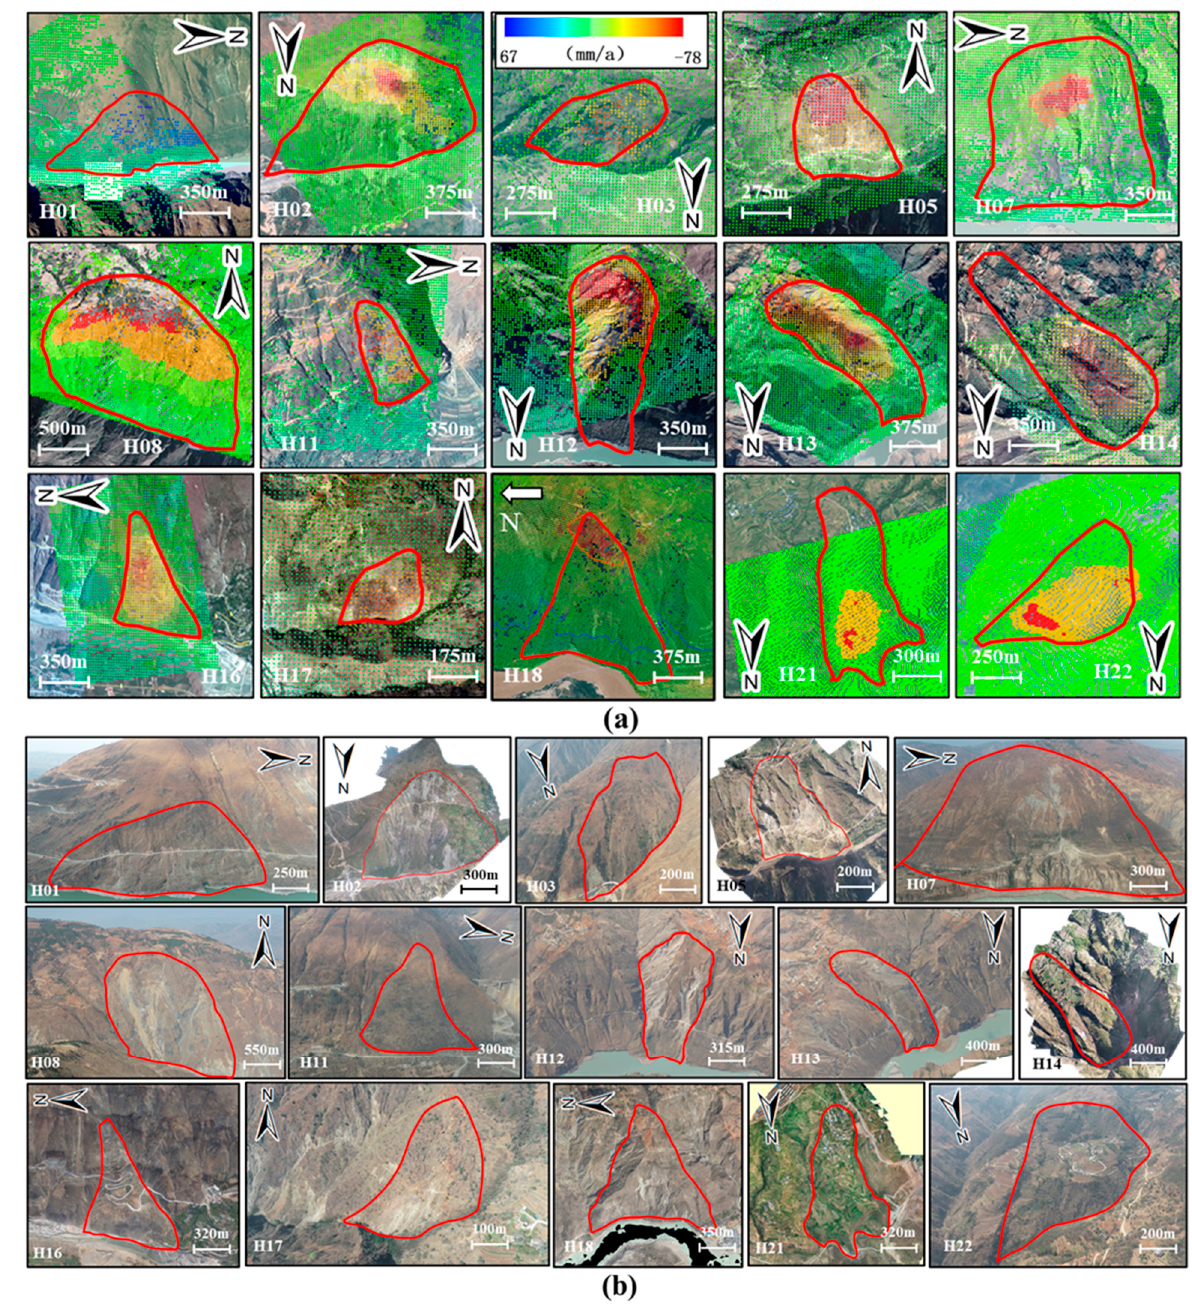
Figure 18. ( a ) Deformation rate and remote sensing interpretation boundary of 15 typical active landslides ( b ) Fifteen typical active landslides were reviewed and photographed; The red line in the figure represents the landslide boundary. The base map in figure ( a ) is from Google Earth image.